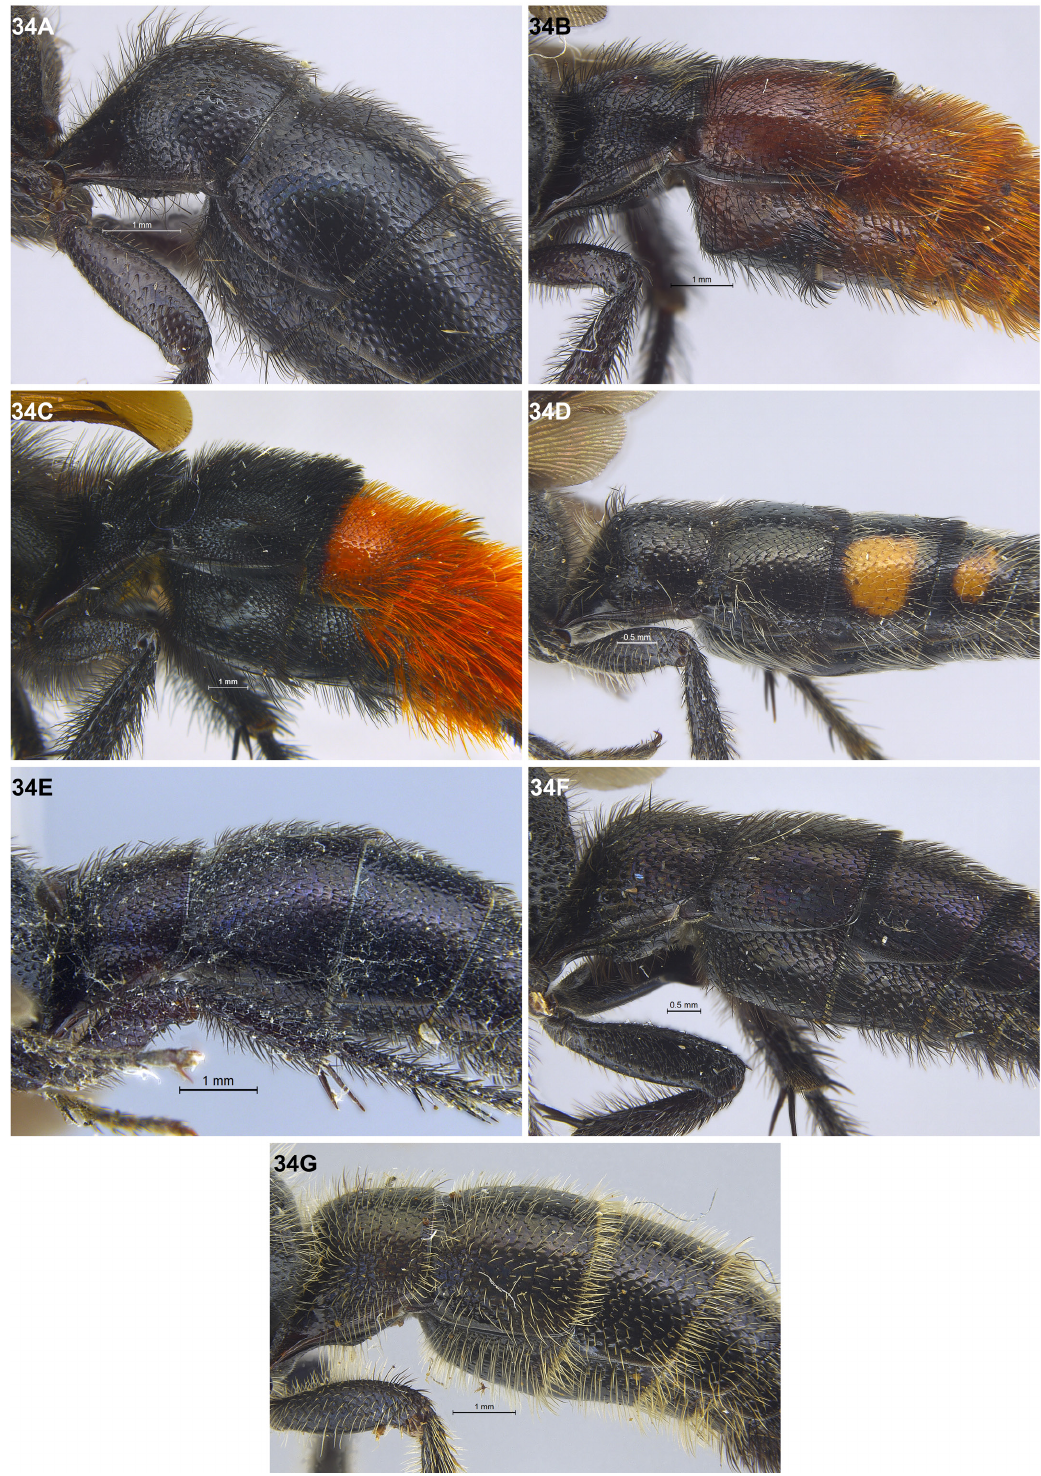
Fig. 34. Males, T1–T3, lateral view. A . Carinoscolia junnanensis (Betrem, 1928). B . Liacos erythrosoma (Burmeister, 1854). C . Megascolia azurea (Christ, 1791). D . Scolia binotata Fabricius, 1804. E . Sc. laeviceps Smith, 1855. F . Sc. pakshaoensis sp. nov., paratype (CBC). G . Sc . superciliaris de Saussure & Sichel, 1864